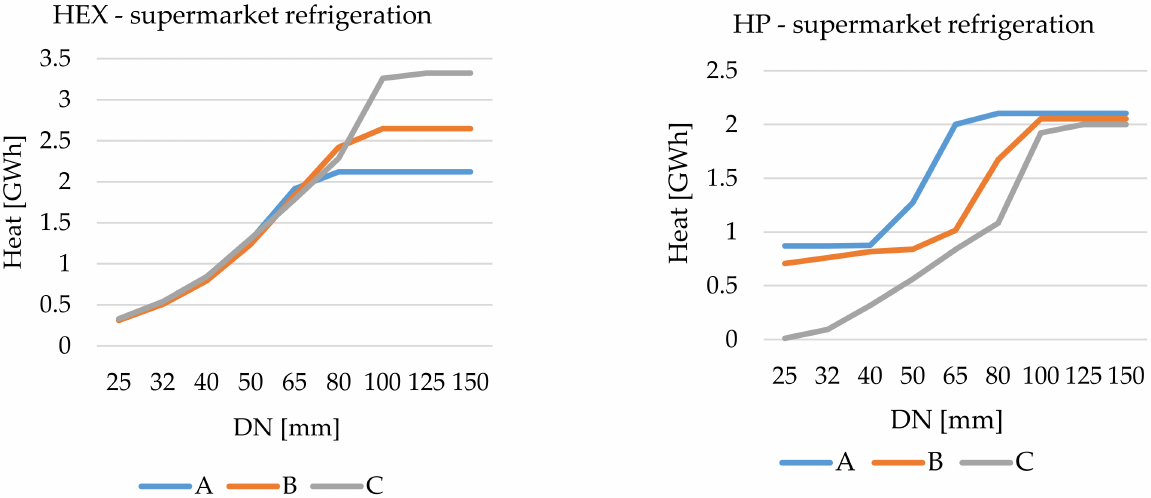
Figure 13. Waste heat from the supermarket refrigeration system injected into the DH network in relation to the connection pipe size, DH temperature regimes, and utilization technology. ( Left ) Heat exchanger; ( right ) heat